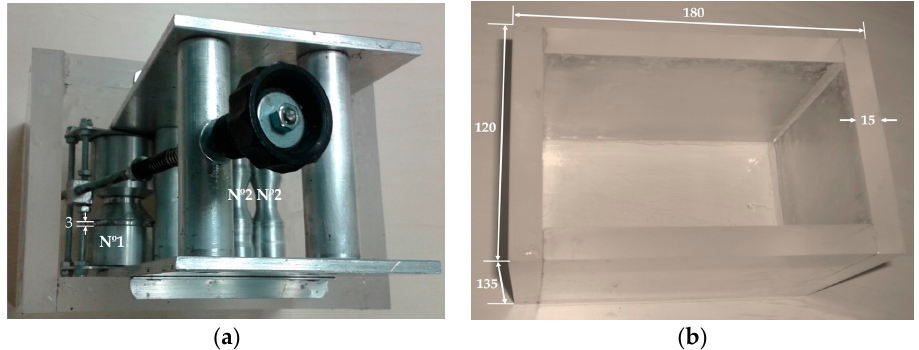
Figure 8. Developed system for roll to roll coating method: ( a ) aluminum roll to roll laboratory device with plexiglass chamber, ( b ) plexiglass chamber.